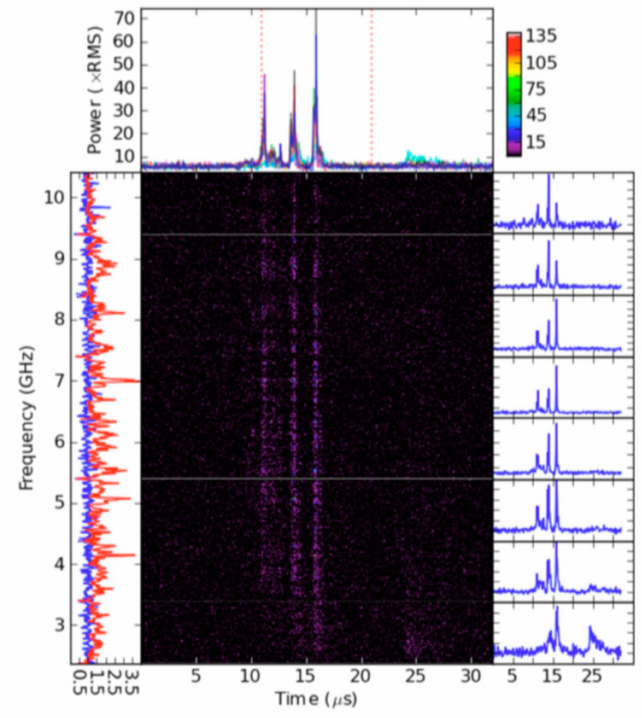
Figure 1. Typical main pulse time-frequency structure of Crab Nebula’s pulsar emission registered in Goldstone-Apple Valley radio telescope